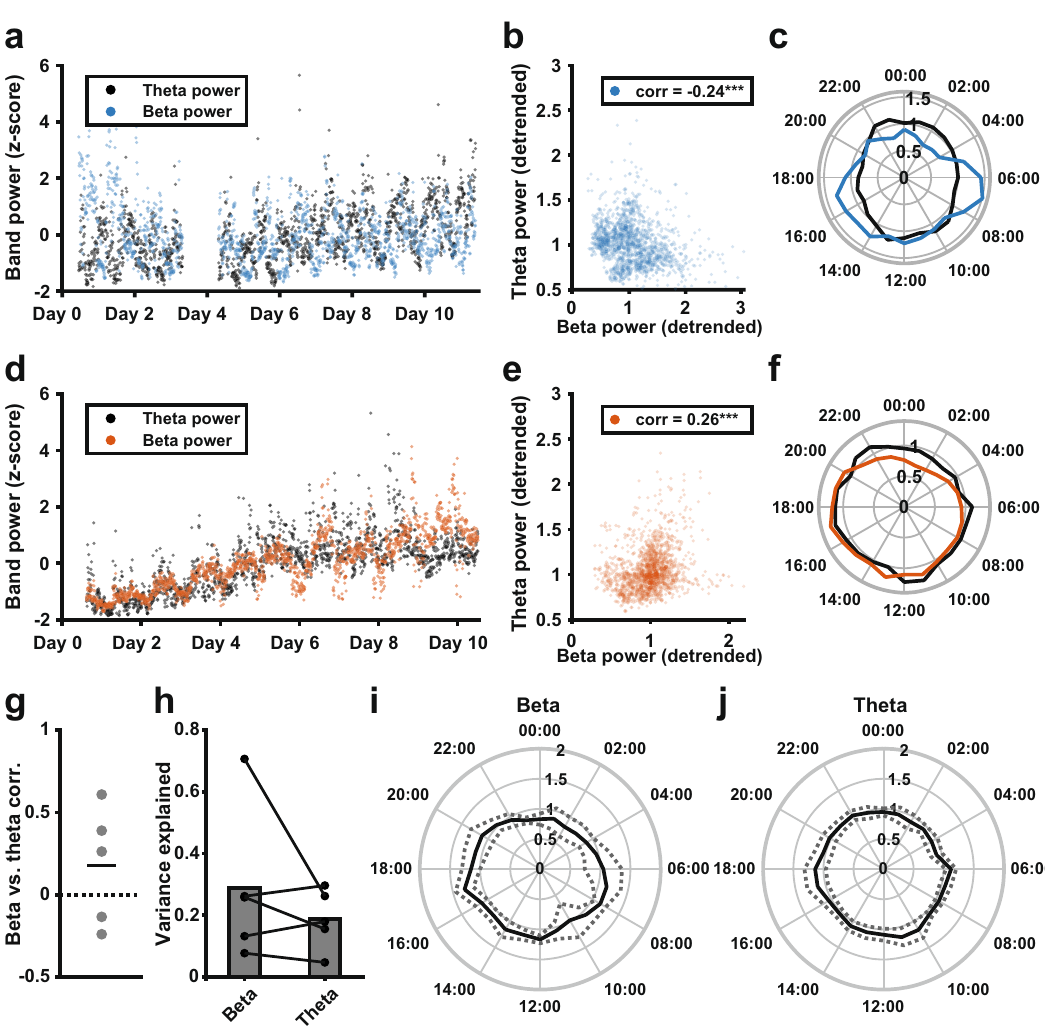
Fig. 3 Correlations in long-term measurements of neural oscillatory power across frequency bands. a Normalized beta power (blue) and theta power (black) were collected concurrently from the left and right STN of one example patient. b Scatter plot of detrended beta power vs detrended theta power shown in a (data were detrended by normalizing values for each day to that day ’ s mean). For this patient, there was a negative correlation between beta and theta ( r = -0.24, p < 0.001). c Median detrended beta (blue) and theta (black) power across the 24-h diurnal cycle, showing different diurnal pro fi les of theta and beta in this example patient. d Normalized beta power (orange) and theta power (black) were collected concurrently from the left and right STN of a second example patient. e Scatter plot of detrended beta power vs detrended theta power shown in d (data were detrended by normalizing values for each day to that day ’ s mean). For this patient, there was a positive correlation between beta and theta ( r = 0.26, p < 0.001). f Median beta (orange) and theta (black) power across the 24-h diurnal cycle, showing the overlap in the diurnal pro fi les of beta and theta power in this second example patient. g Pearson ’ s correlation coef fi cients for concurrently collected contralateral STN beta and theta power measurements (detrended; 0.18 ±0.36, n = 5). h Variance explained by time of day in concurrently collected beta and theta power measurements ( t (4) = 1.1, p = 0.33, 5% con fi dence intervals ( − 0.15, 0.35), paired t -test, n = 5). i , j Mean (solid black) and standard deviation (dashed, gray) concurrent diurnal beta ( i ) and theta ( j ) power pro fi les around the diurnal cycle, across the STN of fi ve